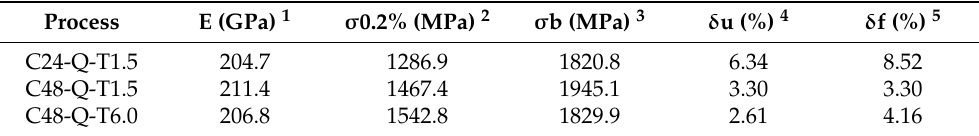
Table 1. Mechanical Properties of the Surface Layer of the